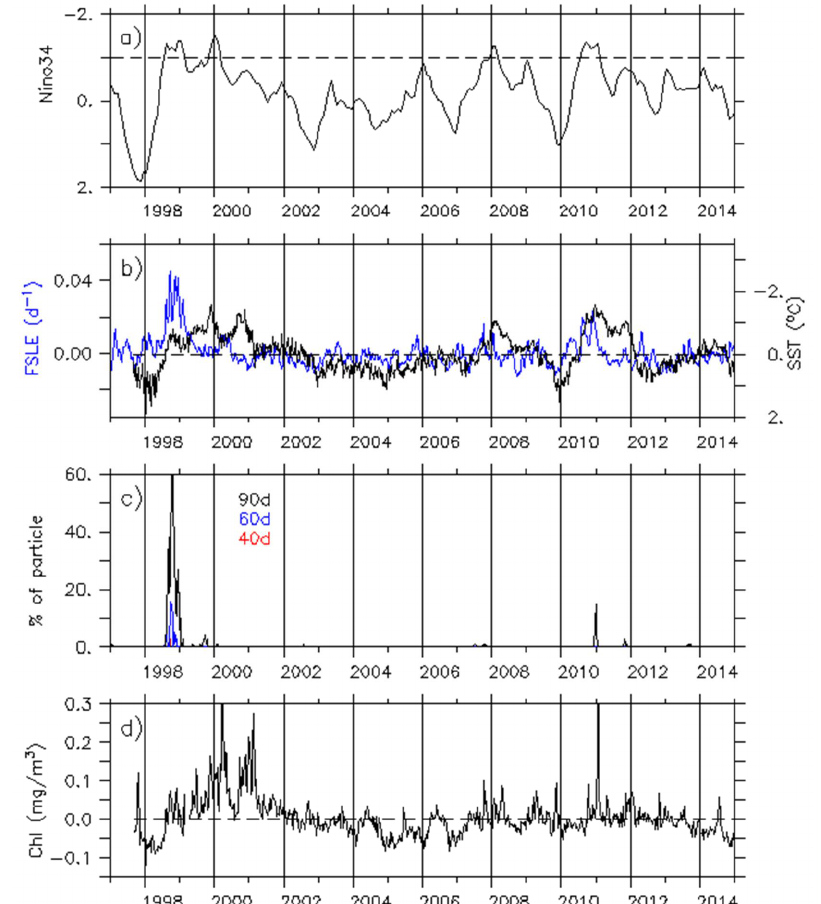
Figure 6. Time series of ( a ) El Niño 3–4 index provided by the Climate Prediction Center (CPC)/National Centers for Environmental Prediction (NCEP) services (the y-axis is inverted). Values lower than the −1 threshold (dash line) highlight moderate to strong La Niña years; ( b ) FSLE (d −1 ; blue line and left axis) and SST (°C; black line and right axis) monthly anomalies averaged over the Marquesas archipelago (11°S–18°S/142°W–138°W); ( c ) Number of particles launched from the northeastern equatorial area and reaching the Marquesas after 40, 60, and 90 days of drift (red, blue, and black lines, respectively); ( d ) Chl monthly anomalies (mg/m 3 ) averaged over the same area as in ( b ).